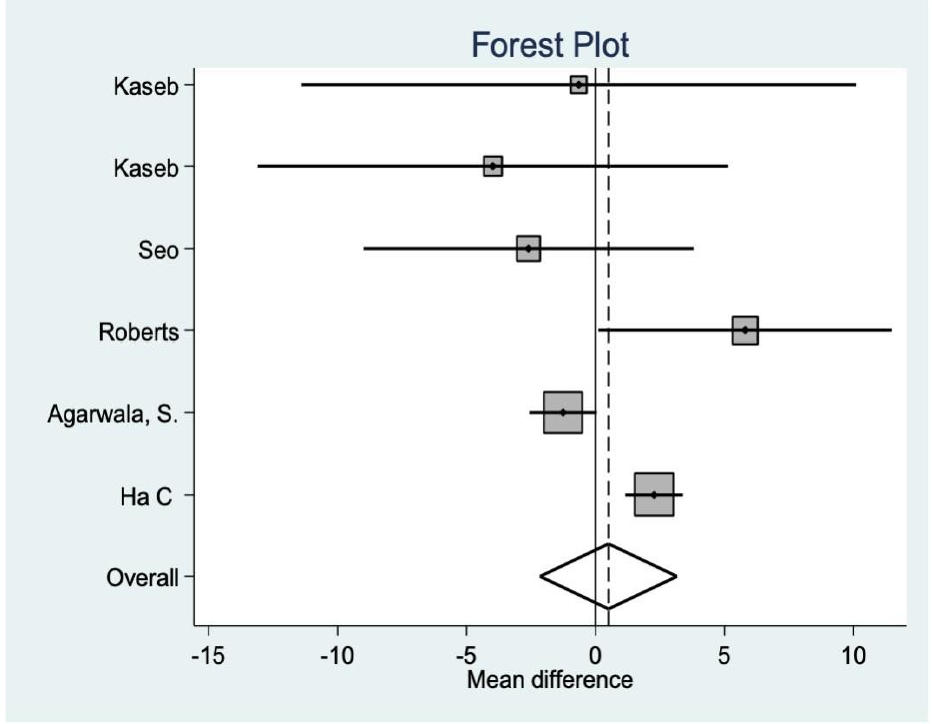
Figure 4. KSS functional data.